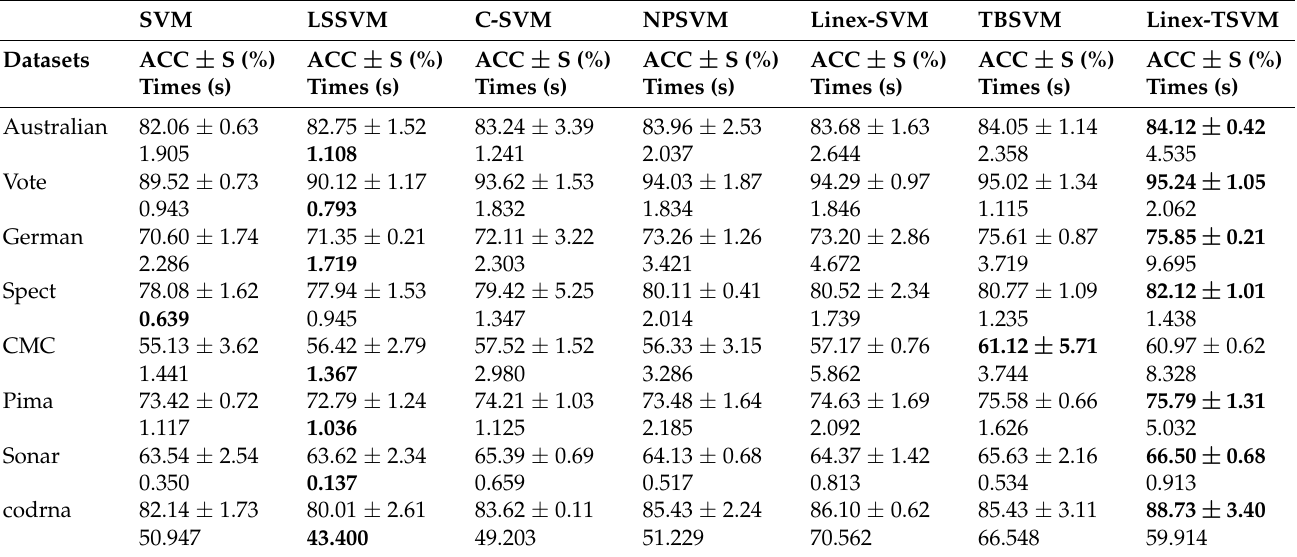
Table 2. Experimental results on UCI datasets without